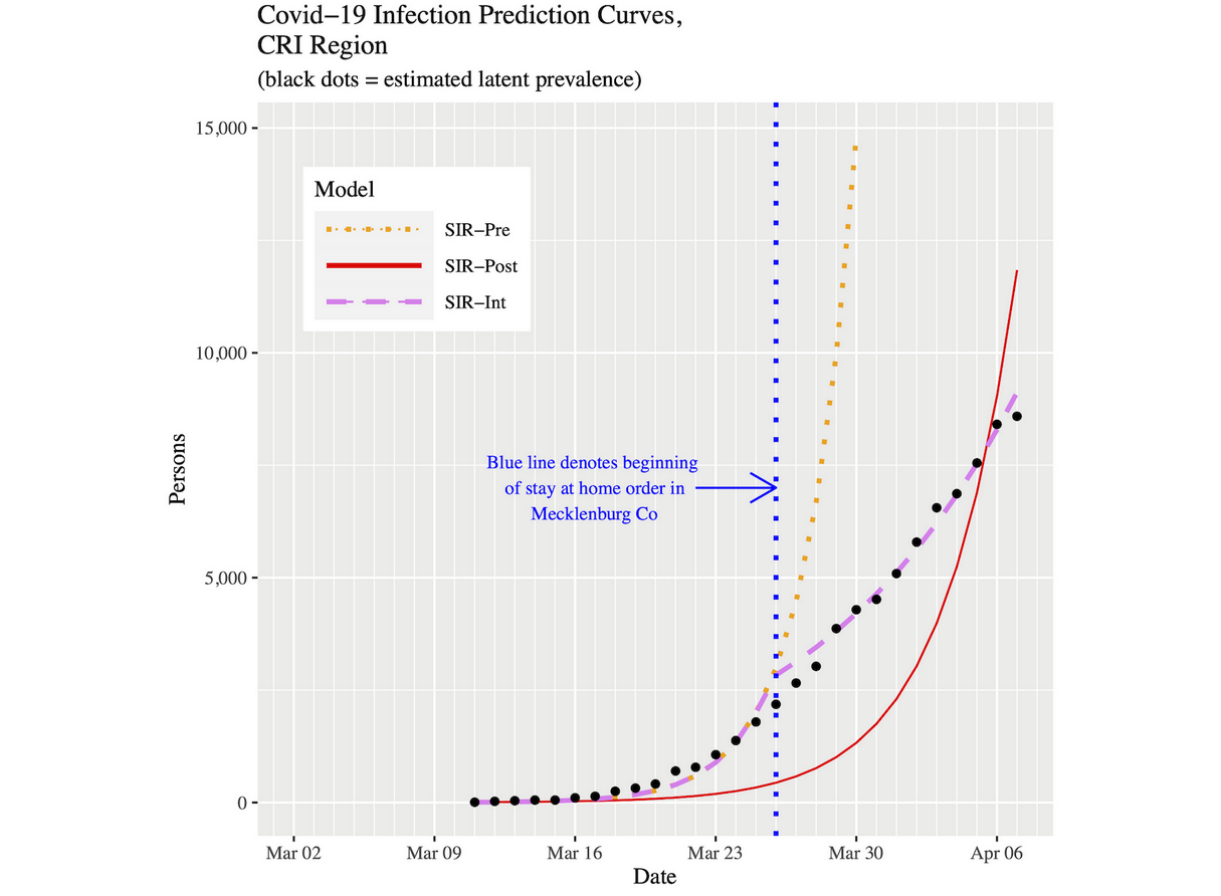
Figure 6. Infection prevalence prediction curves for the CRI up to April 7, 2020. COVID-19: coronavirus disease; CRI: Cities Readiness Initiative; SIR: